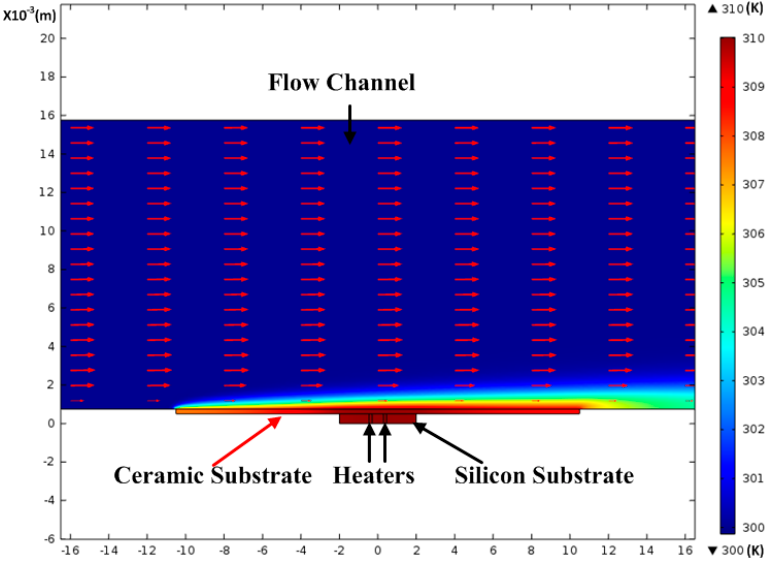
Figure 3. The simulation result of the thermal wind sensor. The ambient temperature is 300 K, and the average temperature of the sensor is 310 K. The wind speed is 2